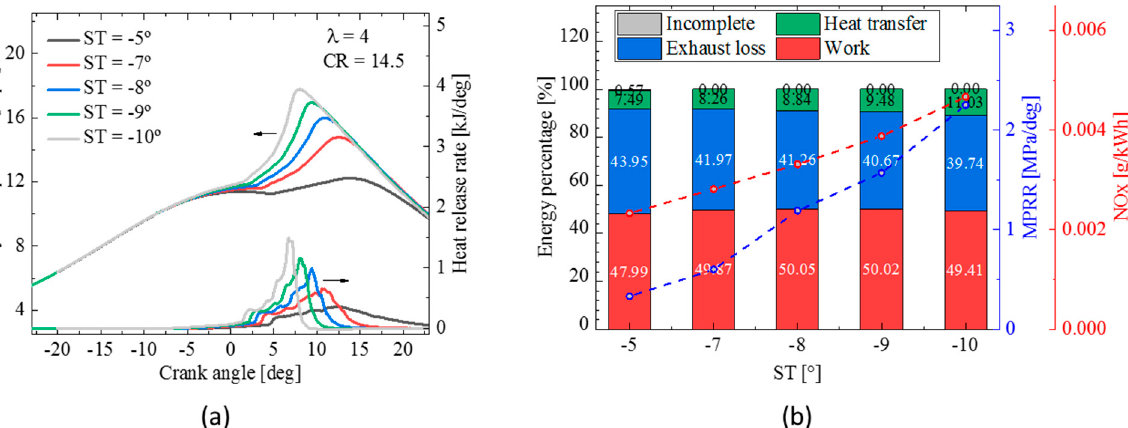
Figure 12. Comparison of: ( a ) pressure and heat release rate traces; and ( b ) efficiency for CR = 14.5 and λ = 4 using different STs.